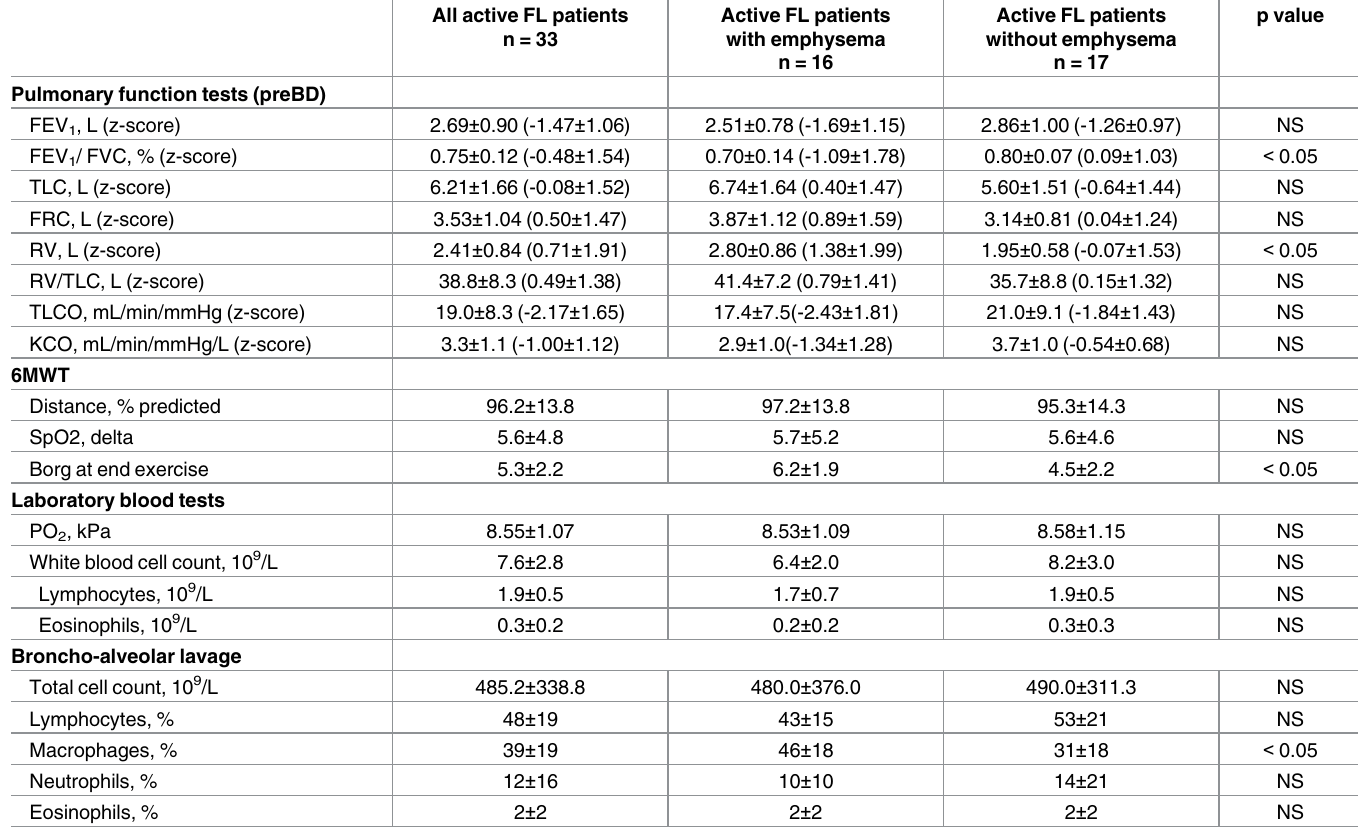
Table 3. Pulmonary function, laboratory blood work and broncho-alveolar lavage in patient with active FL.